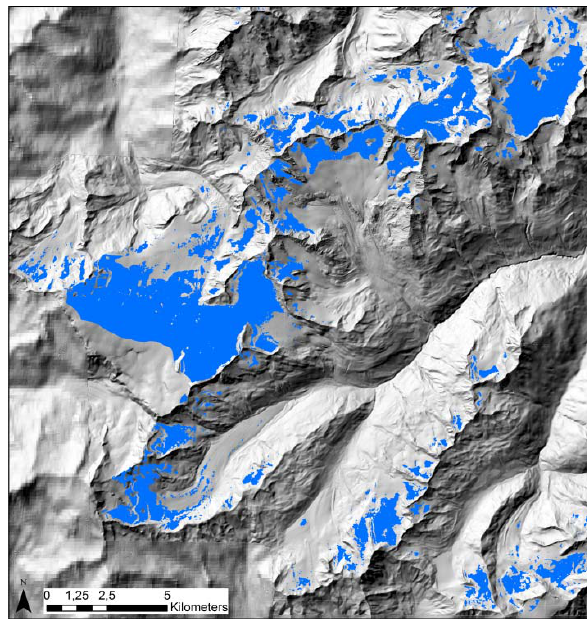
Figure 7. Accummulation Area of Hinteres Oetztal Figure 7 delineates the accumulation area of Hinteres Oetztal. The overlap with the glacier boundaries of the third glacier inventory of North Tyrol acquired with Airborne Laser Scanning in the year 2006 (Abermann et al., 2012) shows a good accordance. Despite the time difference of two days between the TSX and the RS2 imagery, the snow conditions were very stable and hence, both classification results show a good accordance. In contrast to the surrounding glaciers, the upper part of the accumulation area of the Vernagtferner could not completely classified, which is due to the radar effects. The different